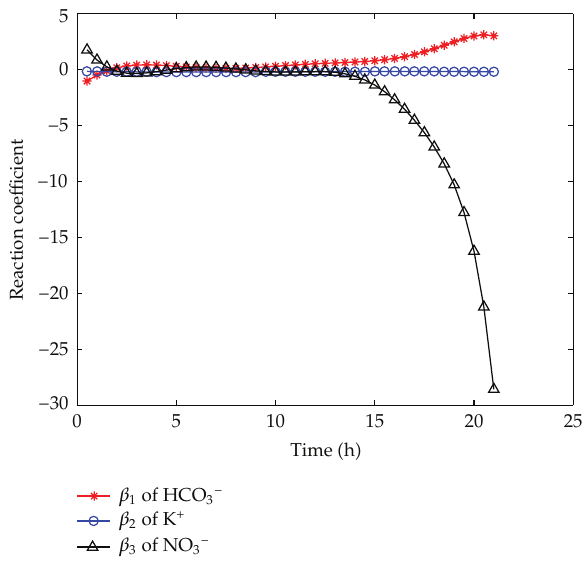
Figure 7: Reaction coe ffi cients with time.